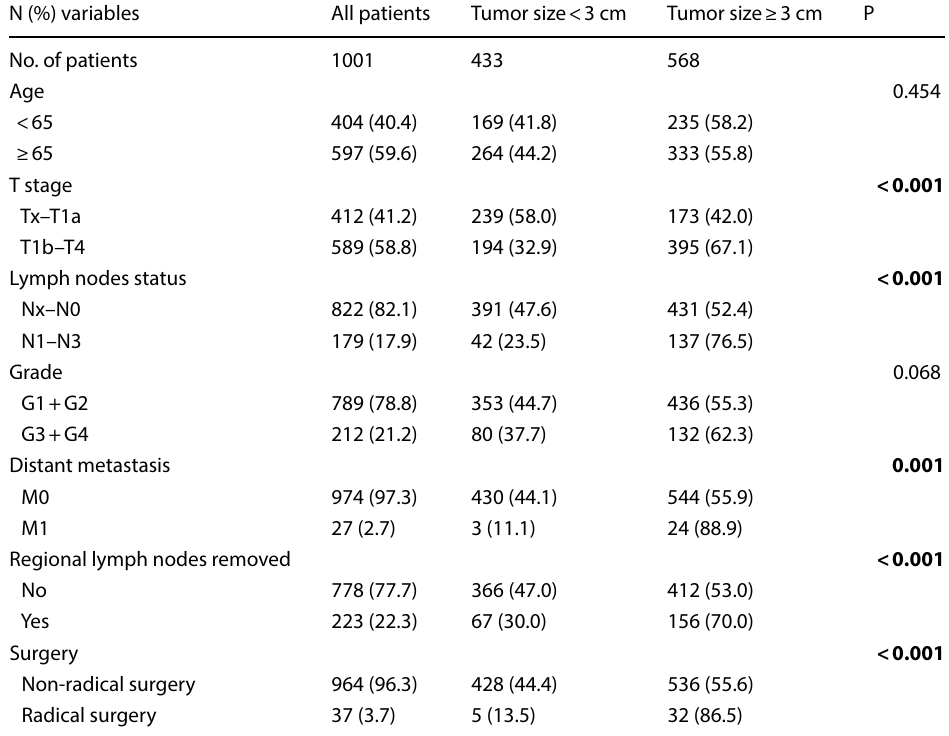
Table 1 Association of primary tumor size with clinicopathologic